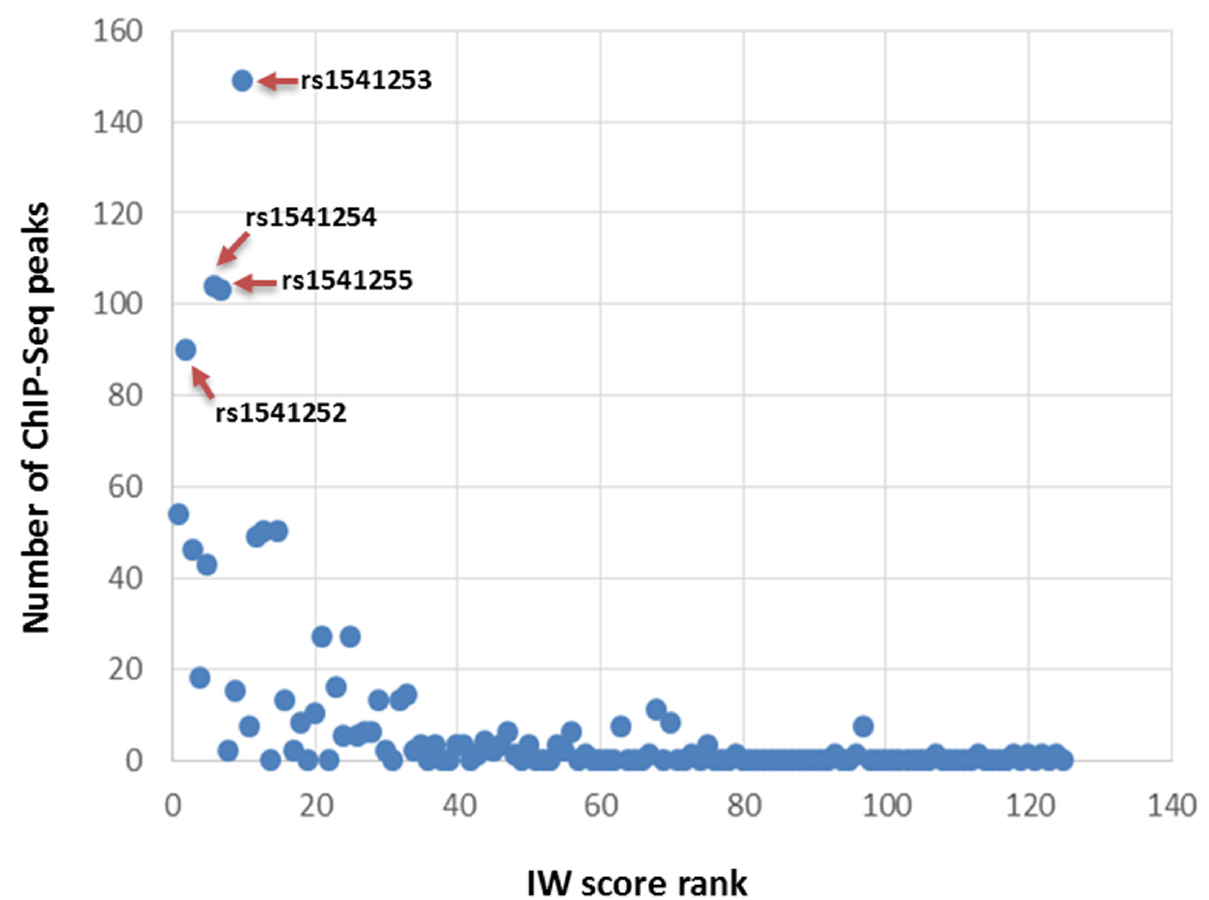
Figure 1. Plot displaying the integrated results for the prioritization of best candidate SNPs. IW scoring method prioritizes functionally relevant noncoding variants. The graph displays the IW score ranks of 125 candidate SNPs. The number of ChIP-seq peaks was extracted from ReMap, which integrates the results of transcription factor ChIP-seq experiments. The graph displays the number of DNA-binding protein ChIP-seq peaks for each candidate SNP. The SNPs with the best IW score rank had the highest number of ChIP-seq peaks. The prioritization was based on IW scoring analysis on the X-axis and the number of ChIP-seq peaks on the Y-axis. The four SNPs rs1541252, rs1541253, rs1541254, and rs1541255 have the highest number of ChIP-seq peaks ( n > 90) as displayed. These SNPs are among the top 10 SNPs according to IW